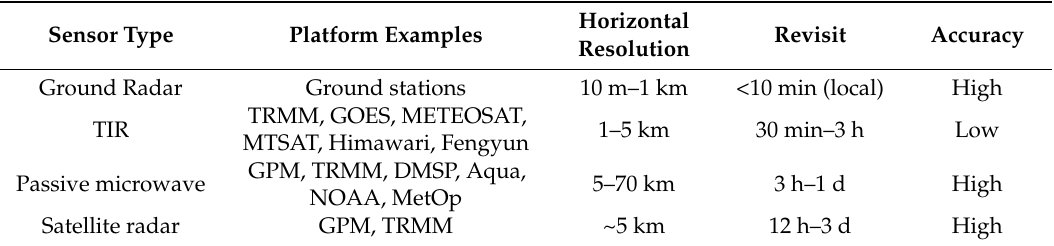
Table 1. Remotely sensed precipitation